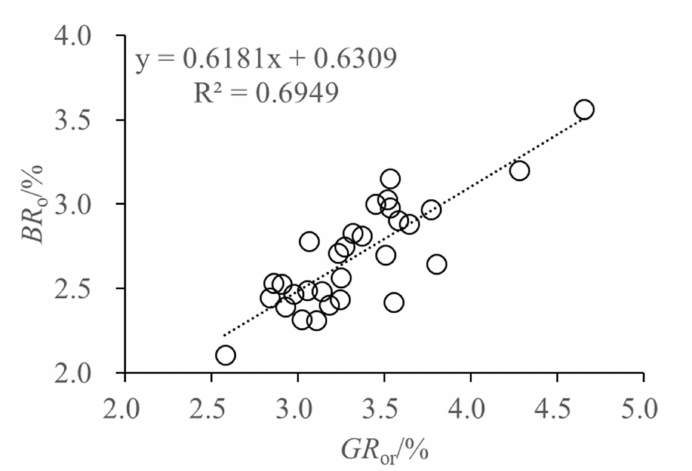
Figure 6. The relationship between the random reflectance of graptolites and solid bitumen (Type A) in the Wufeng–Longmaxi Formations from southern Sichuan